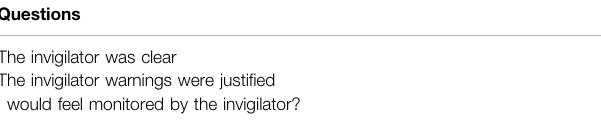
TABLE 1 | List of questions for quality of invigilation — study one.